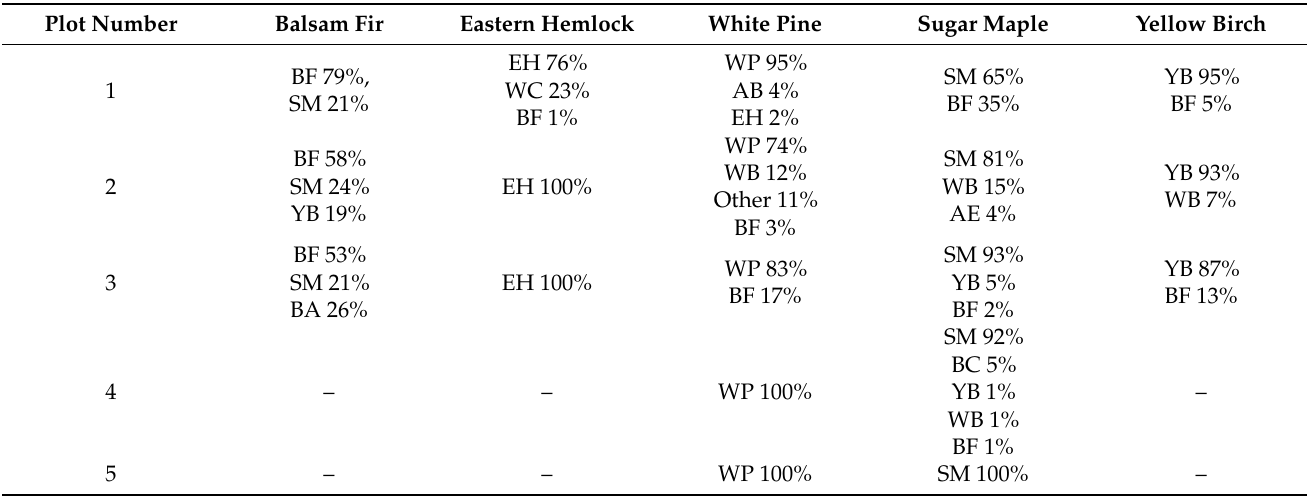
Table 1. Species composition of each plot in percent of total basal area of trees with a dbh >10 cm. Plot Number Balsam Fir Eastern Hemlock White Pine Sugar Maple Yellow